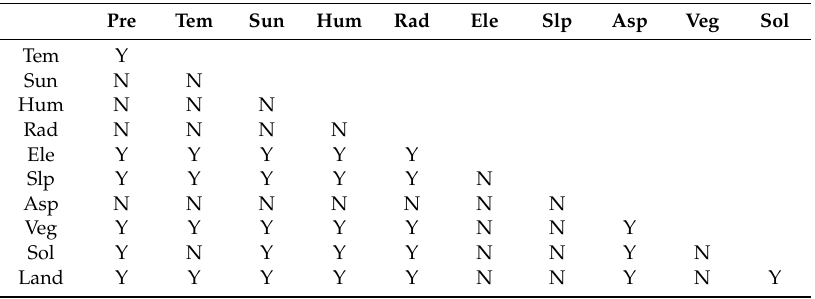
Table 8. The di ff erence between